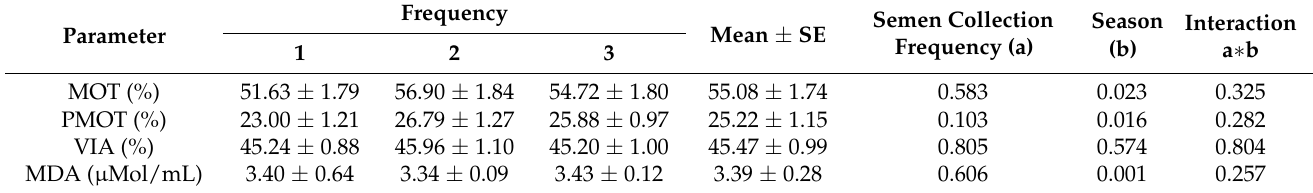
Table 3. Effect of semen collection frequency and season on total motility (MOT), progressive motility (PMOT), sperm viability (VIA), and malondialdehyde (MDA) concentration of frozen rooster semen.